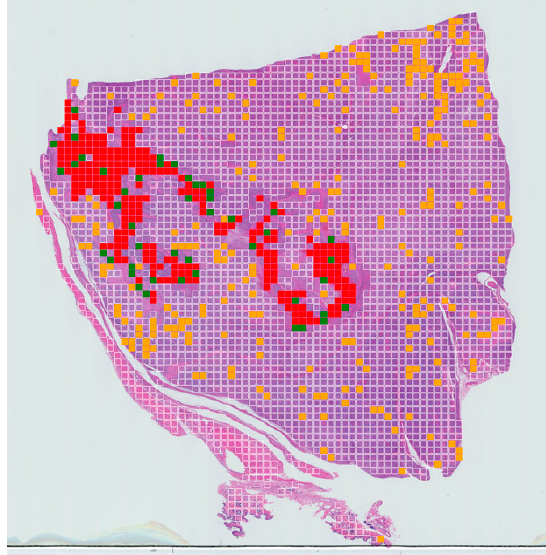
Figure 4. Example of slide-level confusion map showing areas of necrosis within a WSI of canine soft-tissue sarcoma. True positives (TPs) are displayed in red, false negatives (FNs) in green, false positives (FPs) in yellow and true negatives (TNs) in clear. These maps can be used to calculate the percentage of tumour necrosis in a patient and visualise the extent of the tumour necrosis over the whole-slide image.